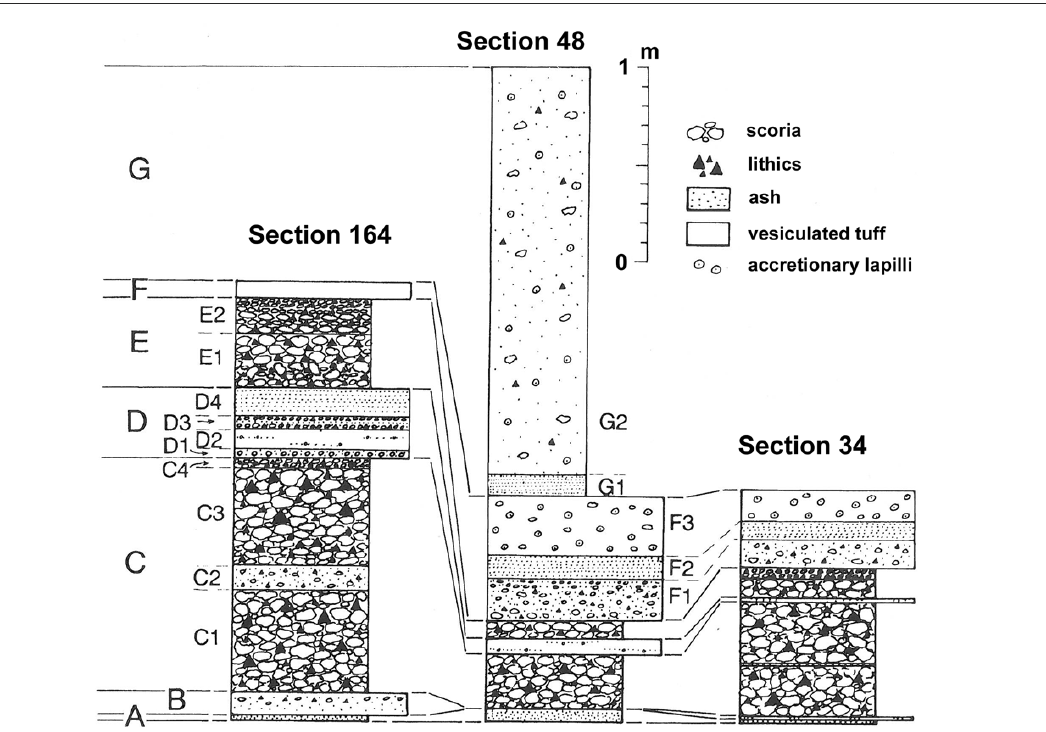
Figure 2. Representative stratigraphic sections of the 122 BC Etna eruption [from Coltelli et al. 1998]. Locations of the sections are given in Figure